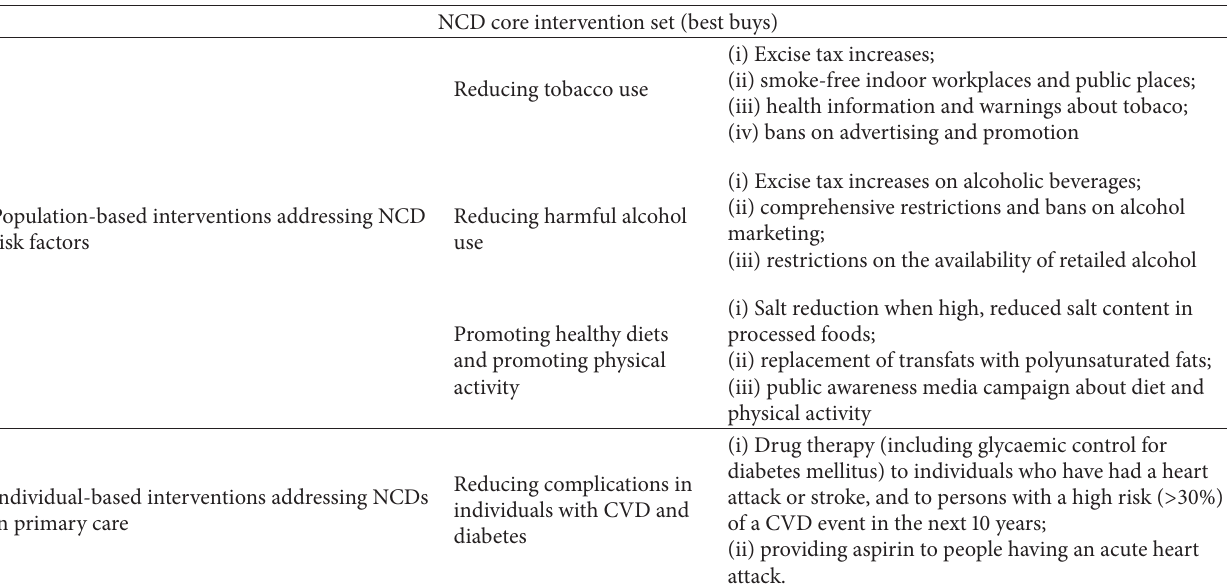
Table 1: A core set of very cost-effective interventions for prevention and control of noncommunicable diseases including cardiovascular disease